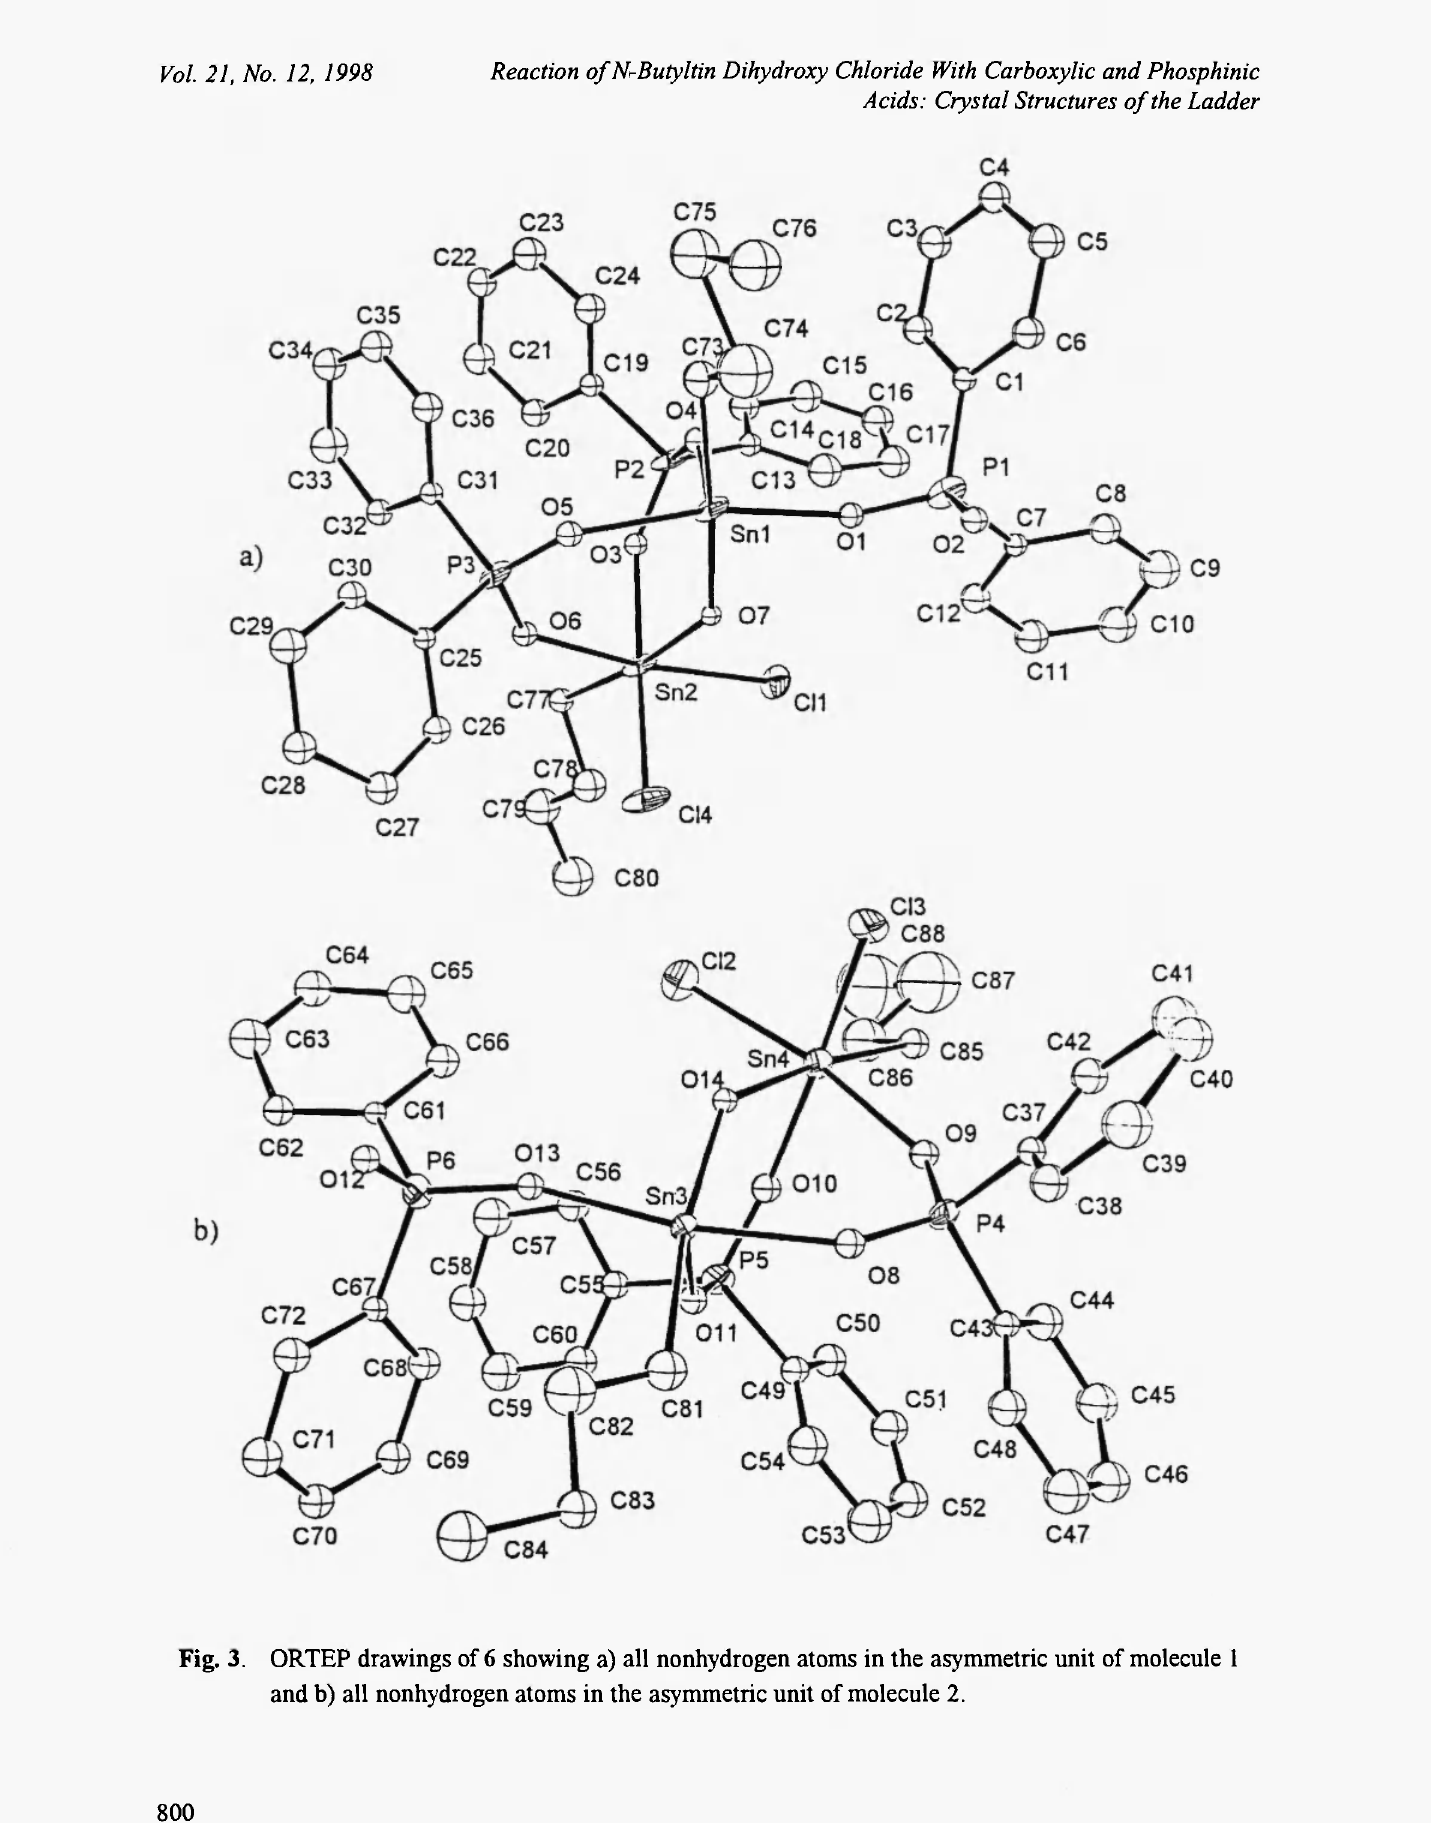
Fig. 3. ORTEP drawings of 6 showing a) all nonhydrogen atoms in the asymmetric unit of molecule 1 and b) all nonhydrogen atoms in the asymmetric unit of molecule